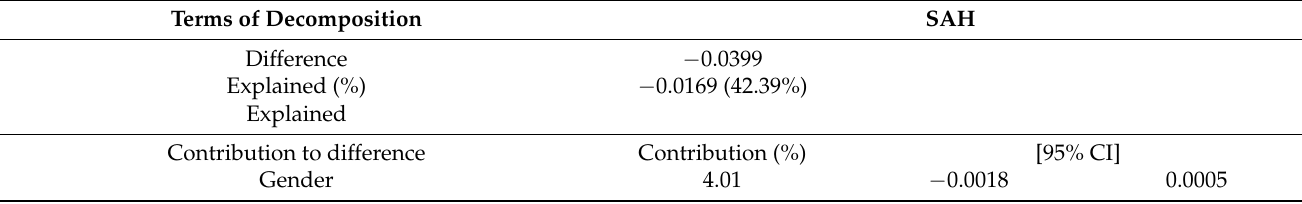
Table 5. Fairlie decomposition of SAH disparity between rural and urban